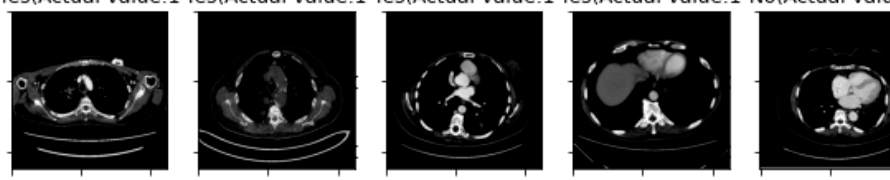
Figure 5. Example of outputs from the first run.